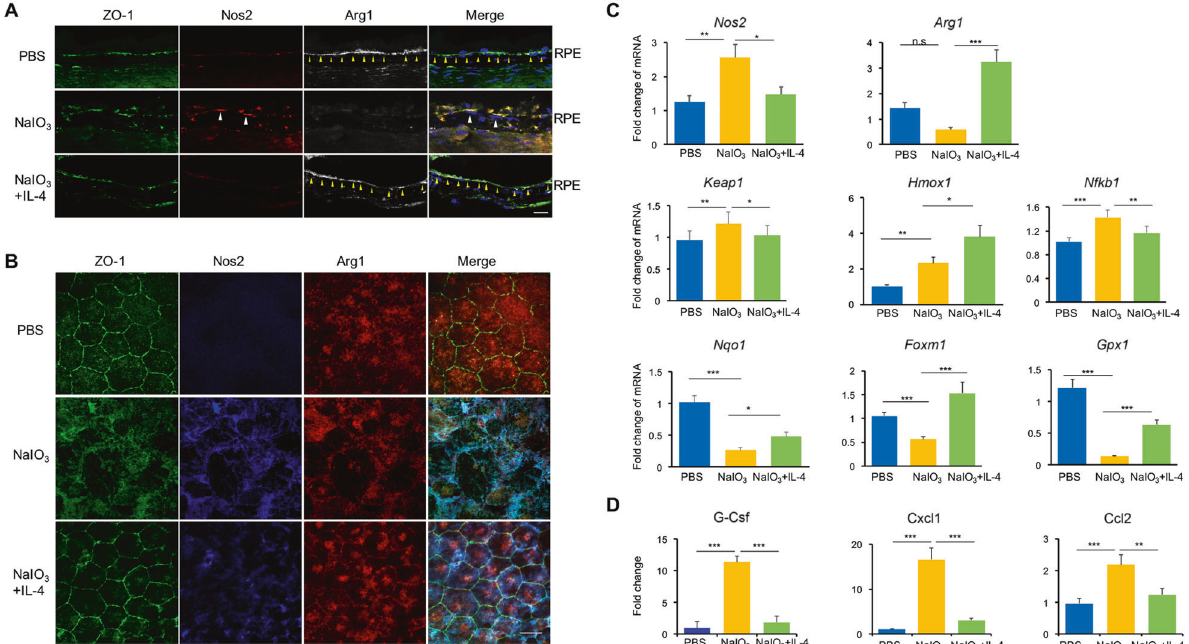
Fig. 6 IL-4 induced antioxidant and anti-in fl ammatory genes expression in vivo. A Immuno fl orence of cryosection showed high expression of Nos2 in response to NaIO 3 in the ZO-1 + RPE monolayer, whereas IL-4 treatment decreased Nos2 and increased Arg1 expression. Scale bar: 20 μ m. B In the RPE fl at-mounts, NaIO 3 disrupted the well-organized hexagonal-shaped RPE cell and induced Nos2 expression elevation, whereas IL-4 treatment reversed it with more organized barrier structures of RPE cells. IL-4 could also suppress the Nos2 expression and promote Arg1 expression within RPE cells. Scale bar: 20 μ m. C qPCR data showed the reduction of Nos2 and increase of Arg1 in the NaIO 3 + IL- 4 group. In addition, IL-4 treatment induced the expressions of anti-oxidative stress-related genes, including Hmox1 , Nqo1 , Foxm1 , and Gpx1 in the NaIO 3 -retina-RPE complex. n = 3. D Luminex results showed elevated expression of pro-in fl ammatory cytokines in the RPE complex of NaIO3-induced model, including G-Csf, Cxcl1, and Ccl2, which decreased after IL-4 treatment. n = 3. Data are shown as mean ± SEM. * P < 0.05, ** P < 0.01, *** P < 0.001, n.s: no signi fi cance, one-way ANOVA